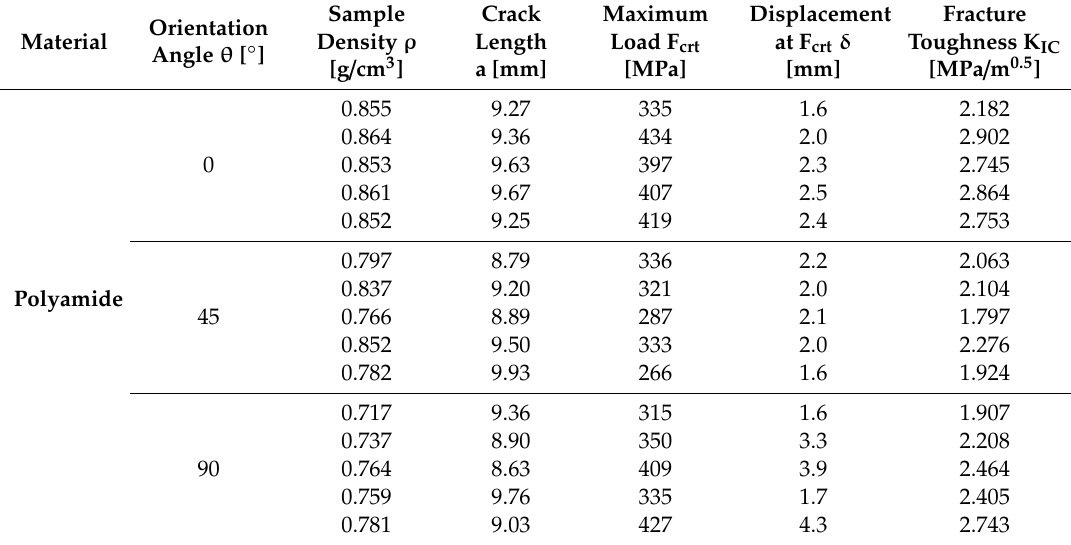
Table 1. Mode I fracture toughness values of polyamide and Alumide samples according to θ .